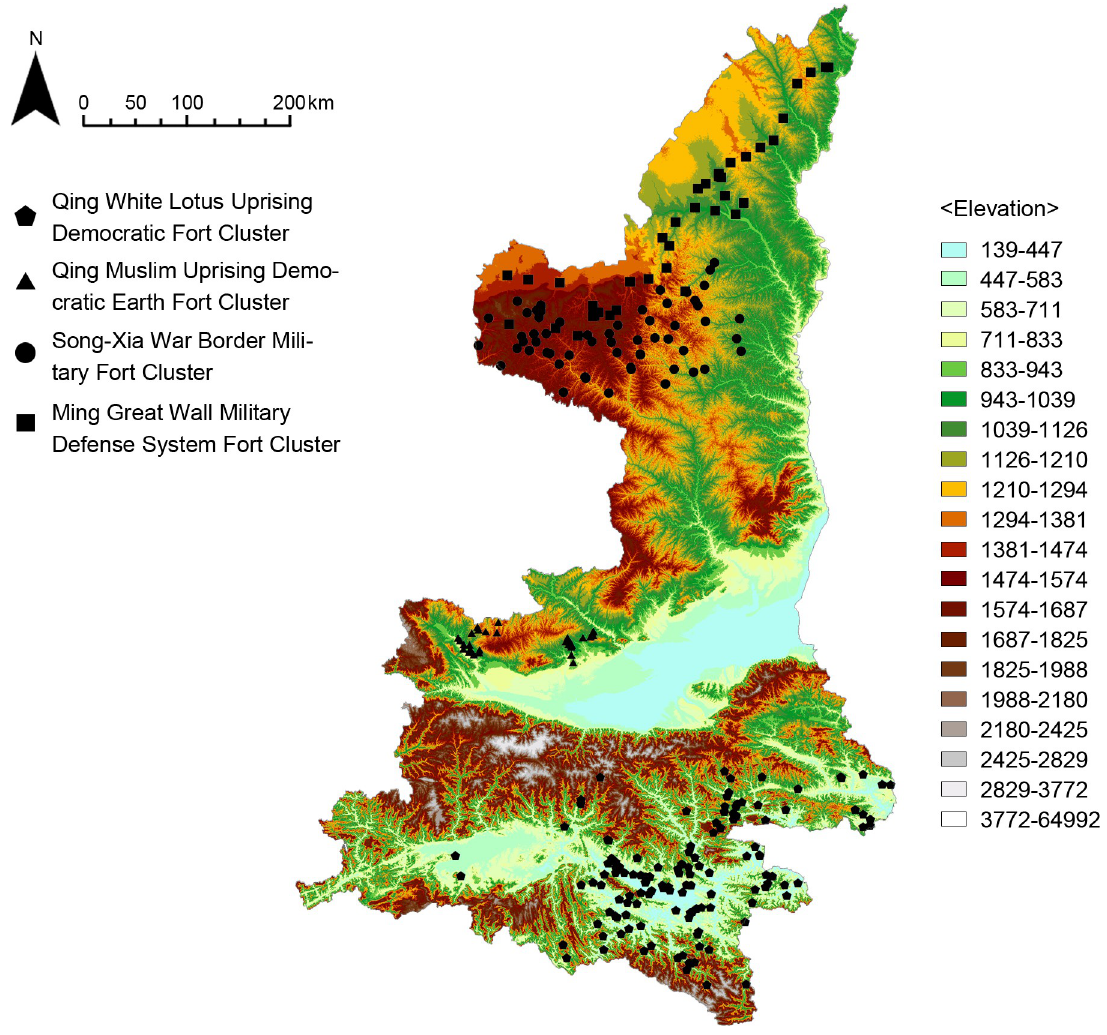
Fig 14. Analysis of